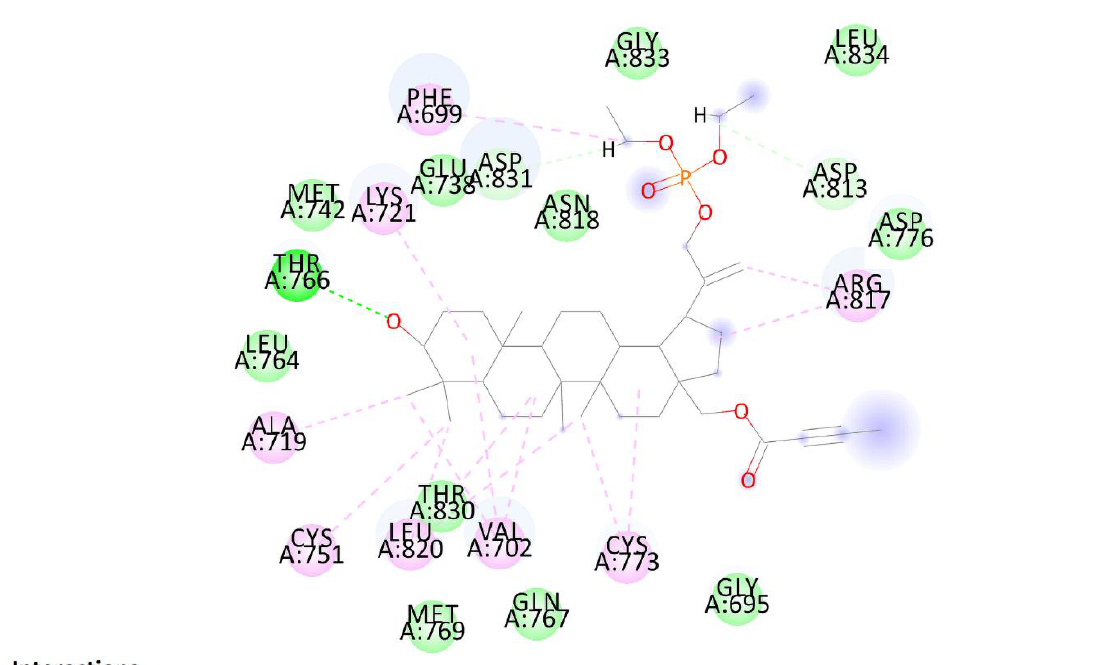
Figure 14. Two-dimensional (2D) binding interaction of 7b with EGFR.